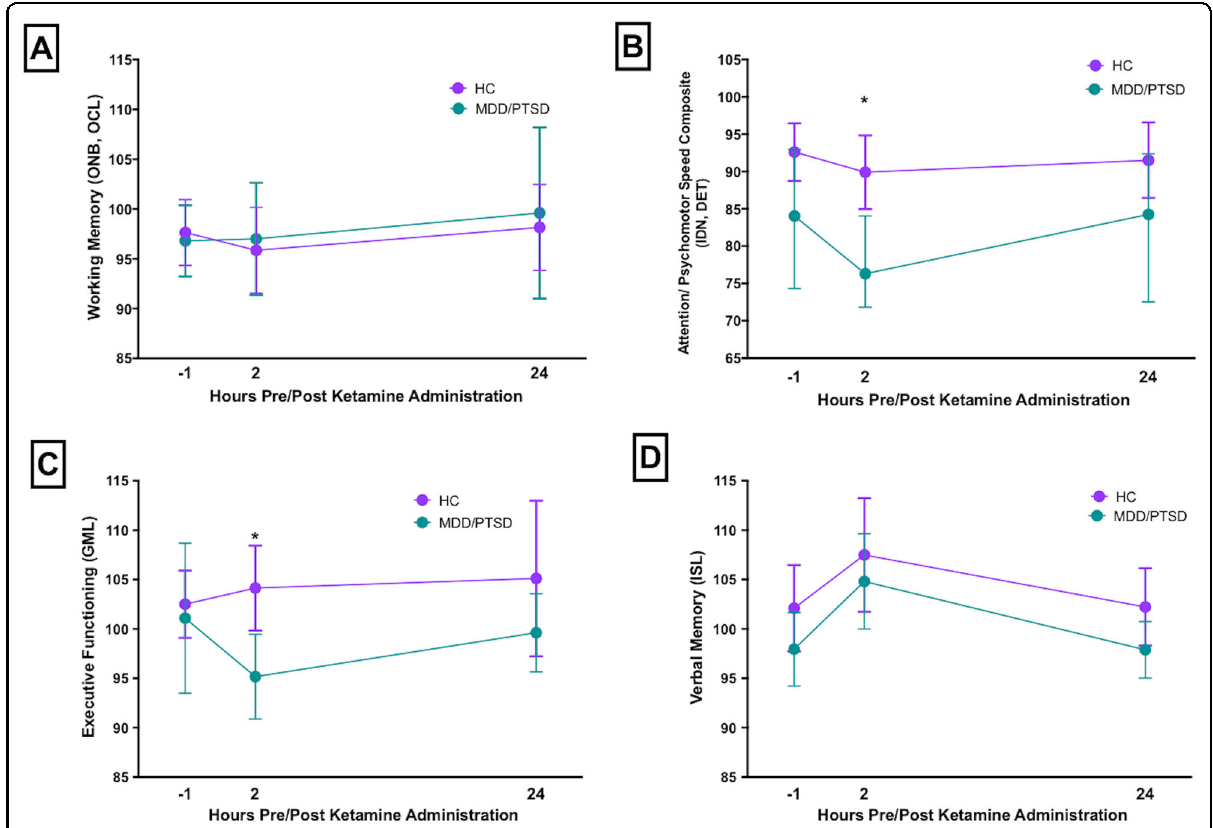
Fig. 2 Mean and 95% con fi dence intervals for normalized Cogstate scores/composite scores across the three study timepoints: pre- ketamine (prior to ketamine administration); 2 h post-ketamine; 24 h post-ketamine administration across groups. HC healthy control, MDD major depressive disorder, PTSD posttraumatic stress disorder, IDN identi fi cation task, DET detection task, OCL one card learning task, ONB, one-back task, GML Groton maze learning test, ISL International Shopping List. * p <